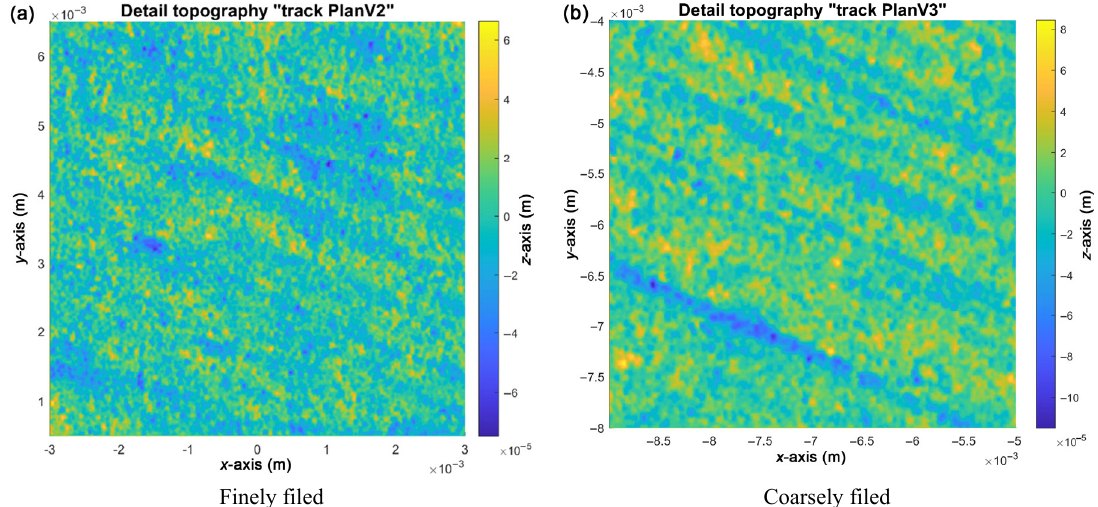
Fig. 7 Section of the topography of the disc friction tracks for (a) finely filed and (b) coarsely filed pin